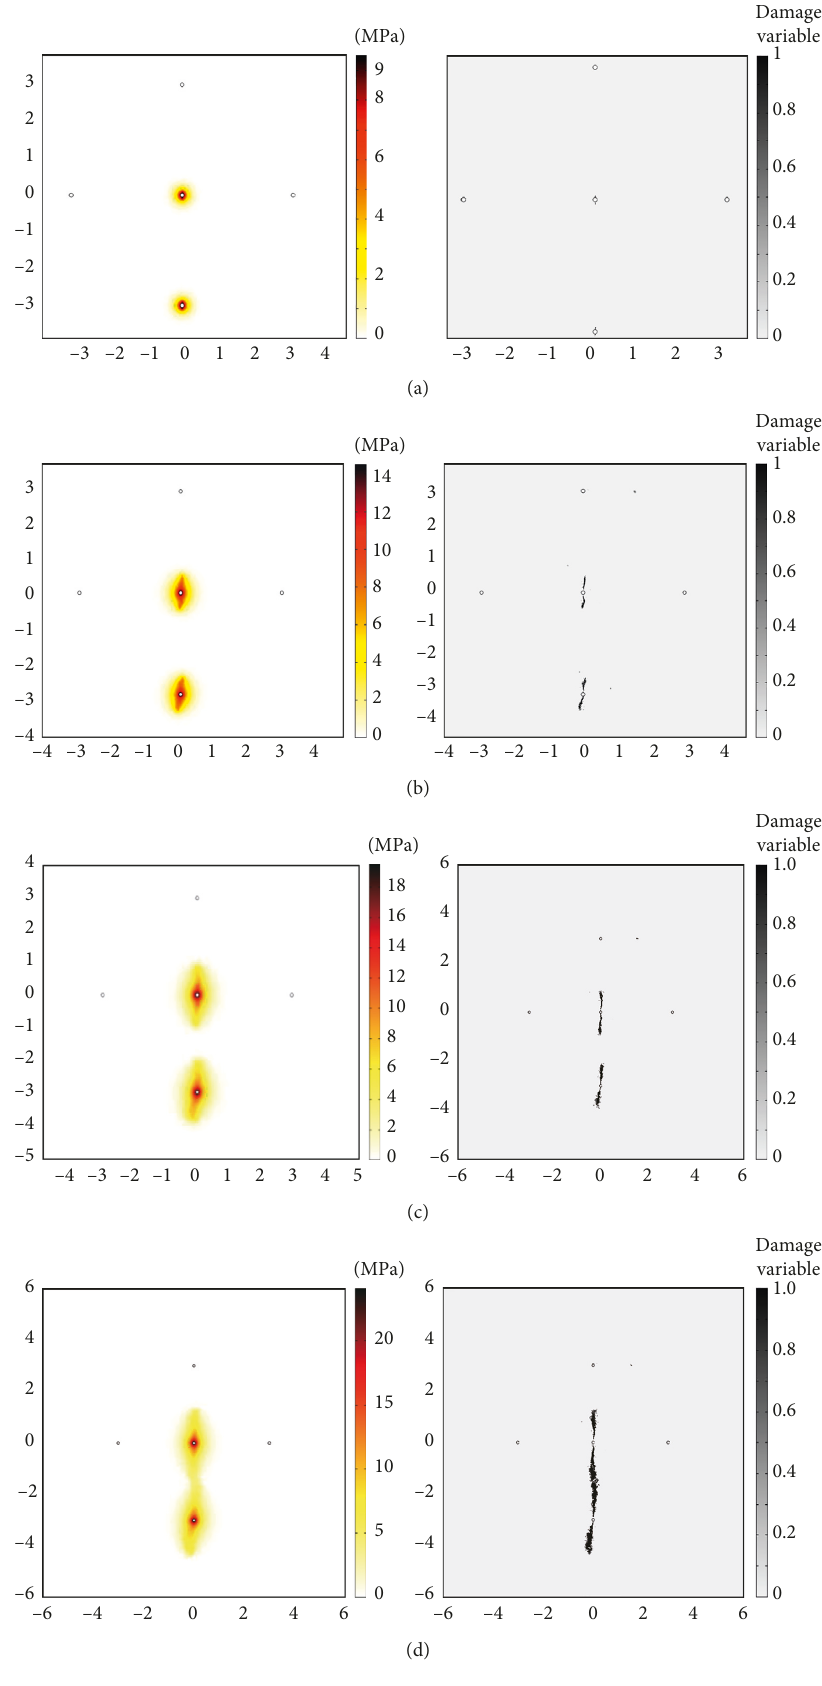
Figure 12: Evolution process of pore pressure (figure on left side) and cracks (figure on right side). (a) Step 9.5_45 ( t � 2.5 min). (b) Step 14.5_3 ( t � 7.5 min). (c) Step 19.5_23 ( t � 12.5min). (d) Step 24_9 ( t �